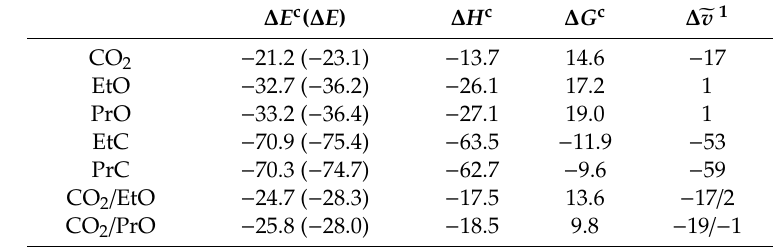
Table 1. Energy ( ∆ E c ), enthalpy ( ∆ H c ), and free Gibbs energy ( ∆ G c ) of adsorption for EtO, EtC, PrO, PrC, and CO 2 on ZIF-8 as calculated at the B3LYP-D3 / TZVP level. All these values are expressed in kJ mol − 1 . For the energy, the value uncorrected for basis set superposition error (BSSE) is also reported for comparison ( ∆ E ). The shift of a representative normal mode with respect to the gas value ( ∆ (cid:101) v , cm − 1 ) is also reported for each molecule: the asymmetric stretching frequency for CO 2 , the breathing ring mode at about 1050 cm − 1 for EtO and PrO, and the C = O stretching frequency for EtO and PrO. In the CO 2 / EtO and CO 2 / PrO clusters, CO 2 molecule is adsorbed on top of the cluster preadsorbing the epoxide molecule. ∆ E c ( ∆ E ) ∆ H c ∆ G c ∆ (cid:101) v 1 CO 2 − 21.2 ( − 23.1) − 13.7 14.6 − 17 EtO − 32.7 ( − 36.2) − 26.1 17.2 1 PrO − 33.2 ( − 36.4) − 27.1 19.0 1 EtC − 70.9 ( − 75.4) − 63.5 − 11.9 − 53 PrC − 70.3 ( − 74.7) − 62.7 − 9.6 − 59 CO 2 / EtO − 24.7 ( − 28.3) − 17.5 13.6 − 17 / 2 CO 2 / PrO − 25.8 ( − 28.0) − 18.5 9.8 − 19 / − 1 − 1 1 Gas phase values: 2435 (CO 2 ), 1296 (EtO), 1295 (PrO), 1901 (EtC), and 1897 cm